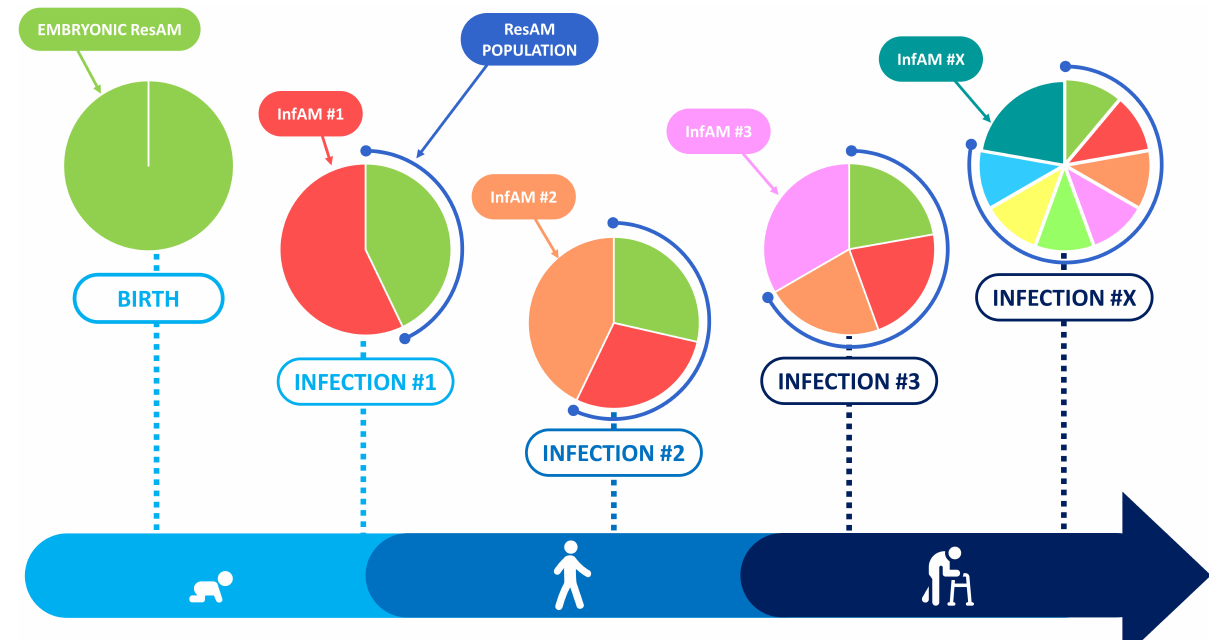
Figure 5. The complexity of human alveolar niche. At birth, the alveolar niche contains embryonic ResAM but during a lung inflammation, a wave of InfAM arrives and they become at the resolution of inflammation, the new monocyte-derived ResAM. Every inflammation generates a new InfAM recruitment wave and at the end, contributes to the heterogeneity of the ResAM population throughout